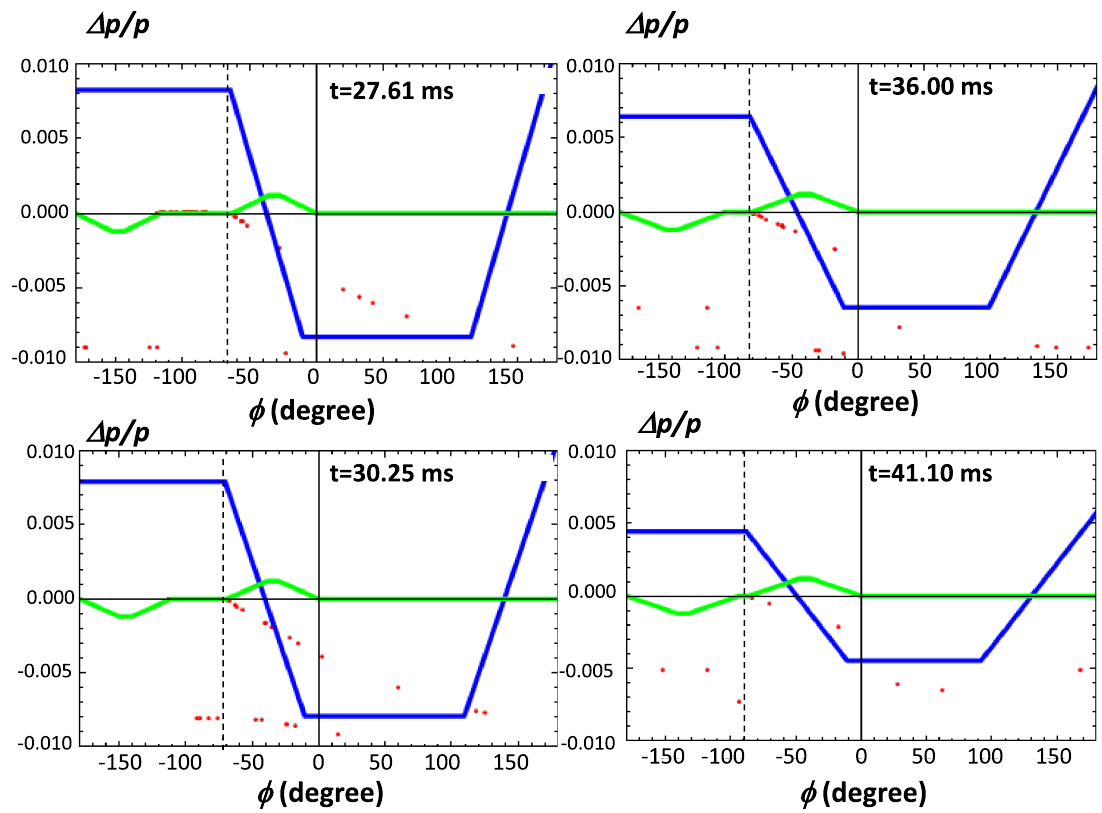
FIG. 11. Phase plots of macroparticles leaving the barrier bucket region, where the bunch core is invisible because its momentum spread is quite small. The positions of broken lines, from which particles leak, should be